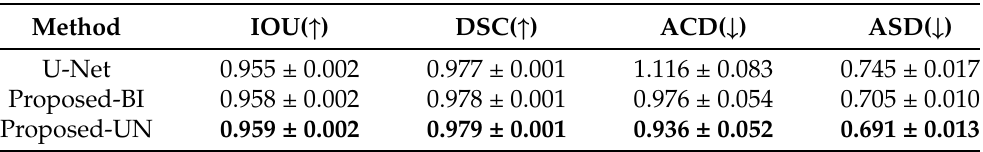
Table 4. Ablation study pertaining to the effect of controlling gradient flows. The best result is shown in